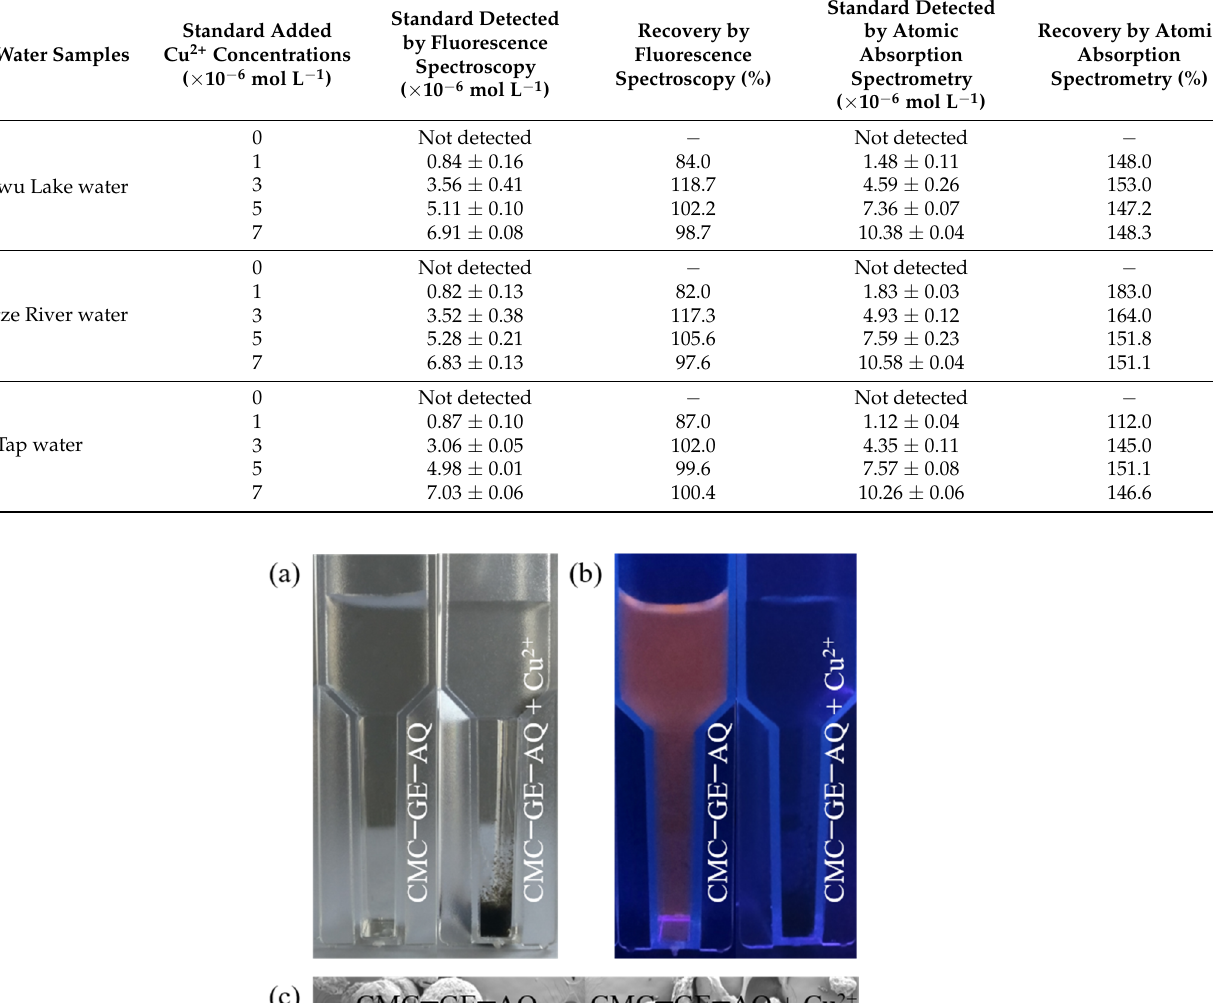
Table 3. Measurements of Cu 2+ in three real water samples by fluorescence spectroscopy and atomic absorption spectrometry.